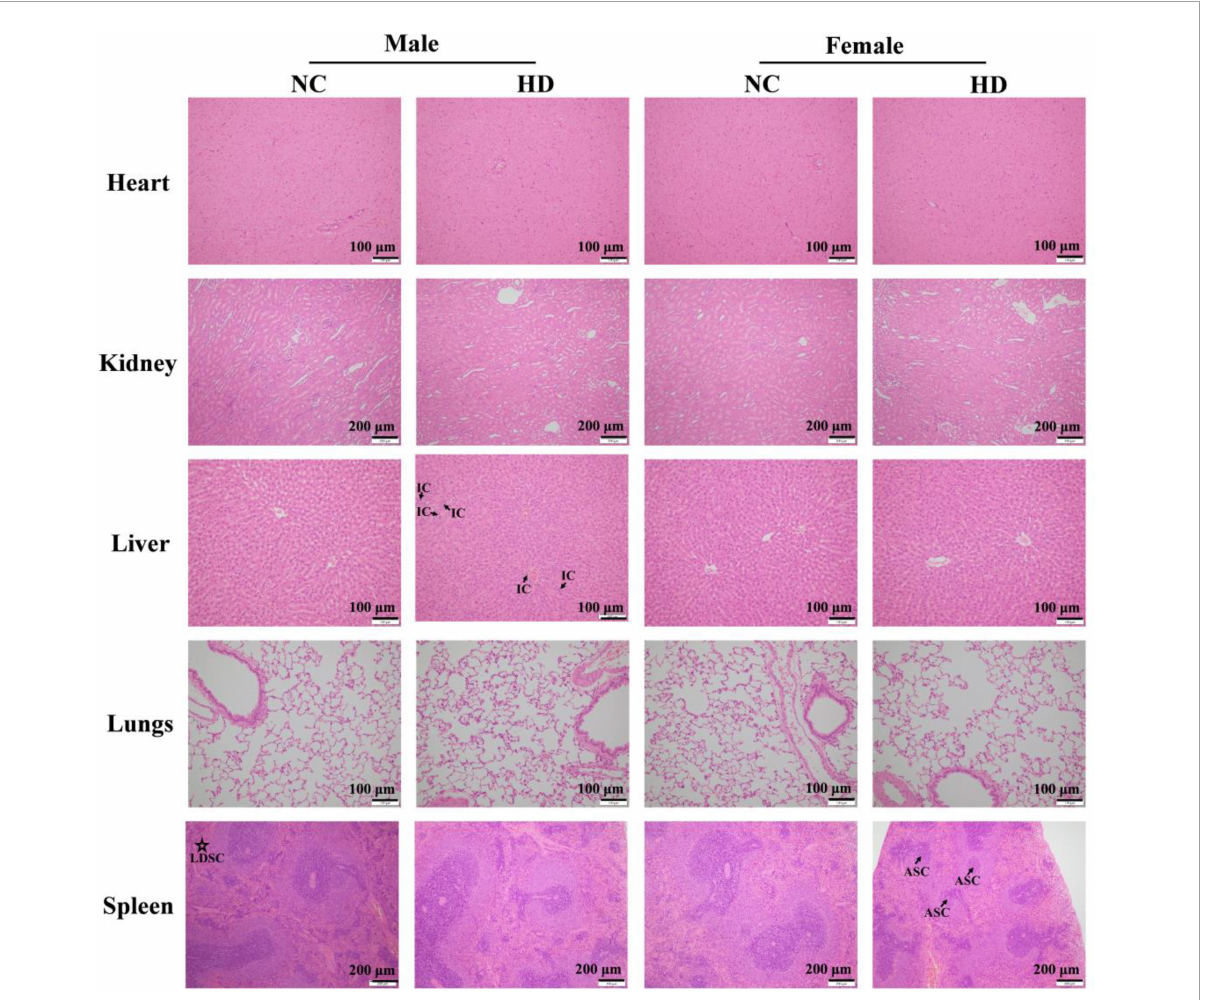
FIGURE4 Photomicrograph of heart, kidney, liver, lungs, and spleen of NC and HD groups after H&E staining in acute toxicity study. The photomicrographs of the liver in a male rat of HD group, spleen in a male rat of NC group, and spleen in a female rat of HD group were chosen as abnormities were observed, and other photomicrographs were selected randomly. IC, LDSC, and ASC refer to inflammatory cells, lower density of spleen cells, and atrophied spleen corpuscles,